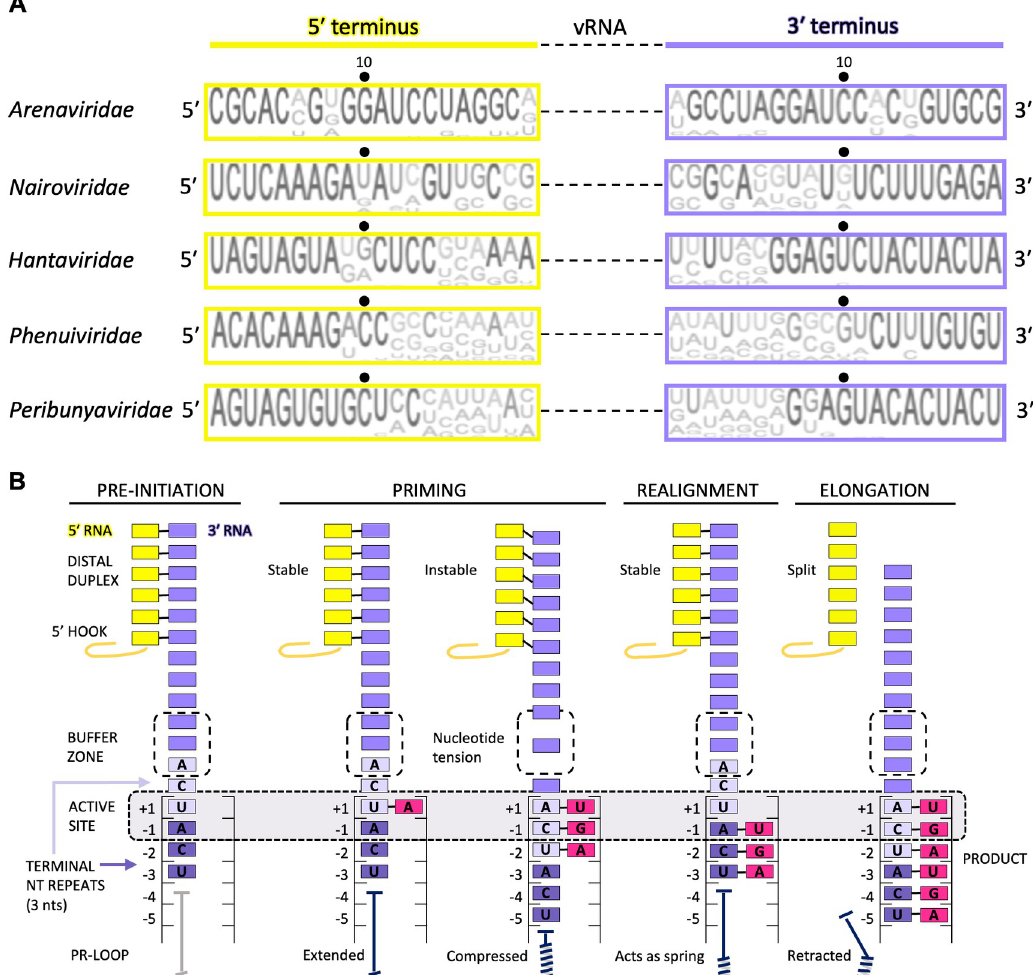
Fig 4. Priming genome replication in the bunyaviruses. (A) Analysis of the sequence conservation and nucleotide complementarity in the 5 0 and 3 0 terminal 20 nucleotides of the vRNA of all genome segments. Sequence conservation was analysed using Jalview [85]. Virus species in the following families were analysed: Arenaviridae ( n = 14), Nairoviridae ( n = 5), Hantaviridae ( n = 14), Phenuiviridae ( n = 14), and Peribunyaviridae ( n = 18), sequences of all genome segments were used. (B) Structure-based model of initiation by prime-and-realign for genome replication exemplified for peribunyaviruses. The 5 0 RNA is colored yellow and the hook shown as a line. The 3 0 RNA is coloured purple with the 3-nt repeats colored light and dark purple. Incorporated nucleotides (product) are coloured in pink. The PR-loop is shown in dark blue except for the pre-initiation panel, where its position is speculative and it is therefore colored in grey. The binding pocket of nucleotides A6, C7, and A8 at priming stage, called buffer zone, is surrounded by a dotted square and labelled. The proposed successive steps (labelled above) of the models are presented from left to right. nt, nucleotide; PR-loop, prime-and-realign loop; vRNA, viral